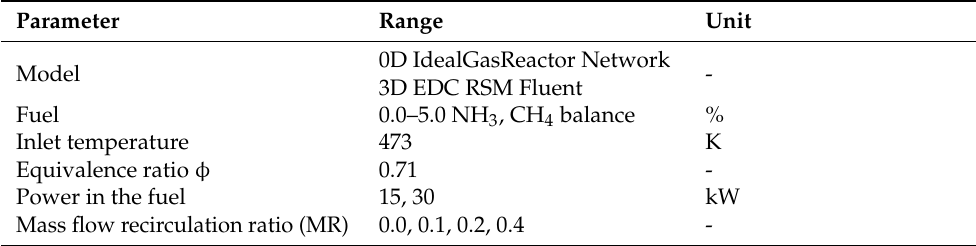
Table 2. Numerical analysis variable